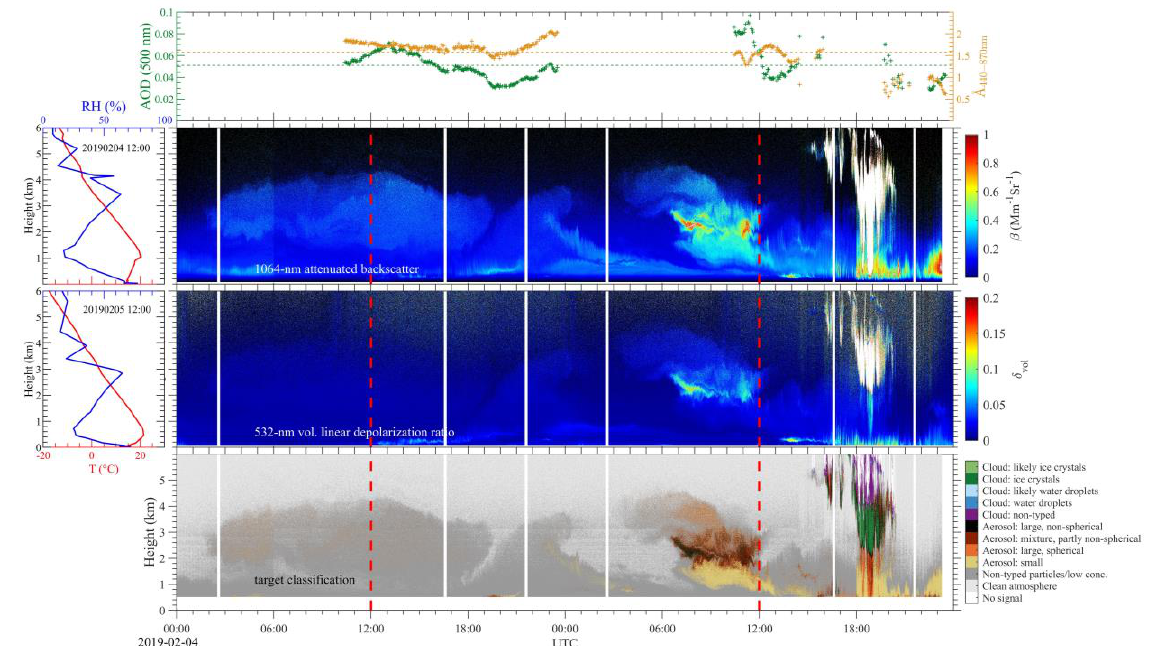
Figure 1. From the upper to the lower panel: AOD (500 nm) and Ångström exponent (440/870 nm), attenuated backscatter coefficient at 1064 nm (sr -1 m -1 ), volume depolarization ratio (%), and target classification reflecting the atmospheric conditions over Punta Arenas from 04.02.2019 to 05.02.2019. Within the study period, two radiosonde launches took place (depicted with red dashed lines). The corresponding temperature and relative humidity profiles can be seen on the left